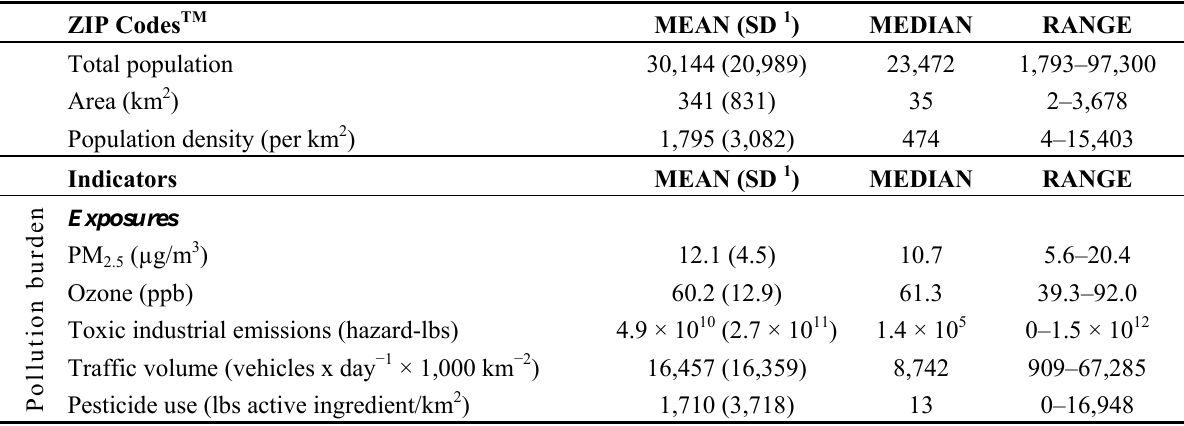
Table 1. Indicators included in the pilot analysis (n =